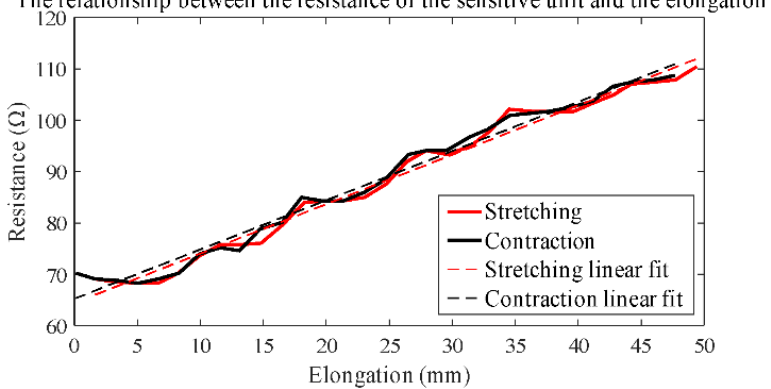
Figure 4. The tensile testing results of the flexible textile sensor.